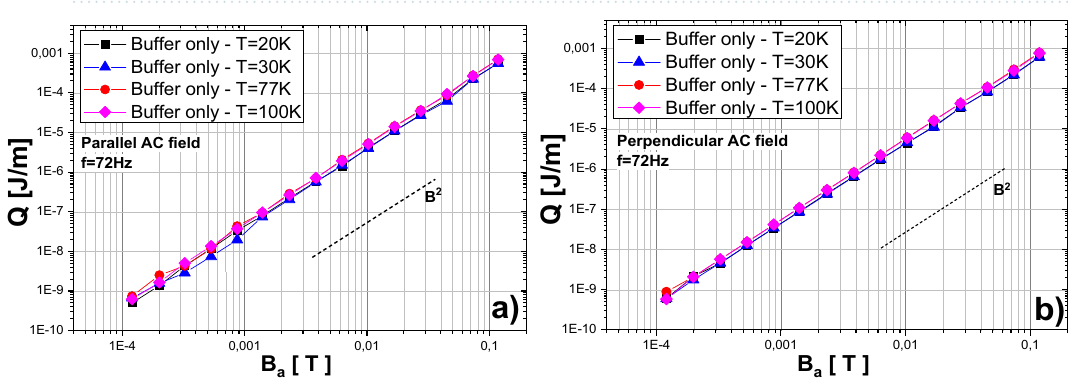
Figure 7. ( a ) Comparison of magnetization AC loss measurement in parallel field of insulated tape stack versus measurements of same stack without superconducting layer at 25 and 35 K (shown quantity is AC loss per cycle). ( b ) The same comparison at temperature 25 K and two frequencies 72 Hz and 144 Hz.